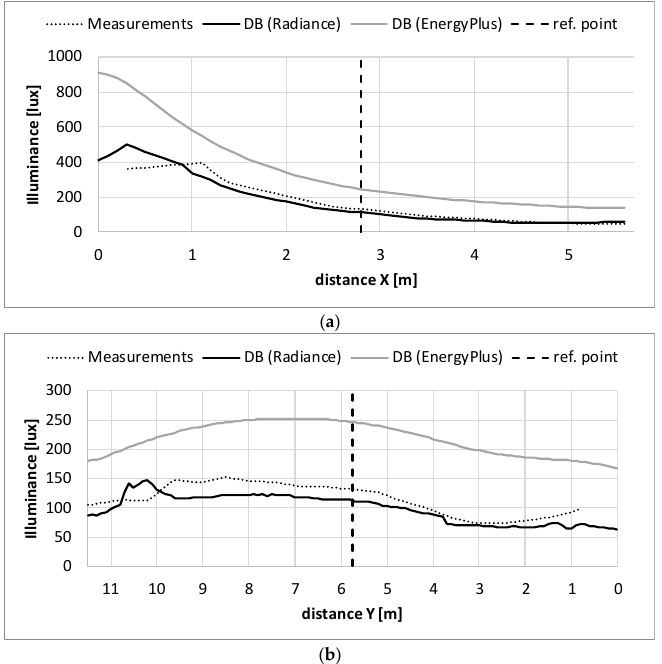
Figure 7. Daylight illuminance profiles in the room for cloudy conditions (11 January 2019 9:00) ( a ) along the width ( b ) along the length.